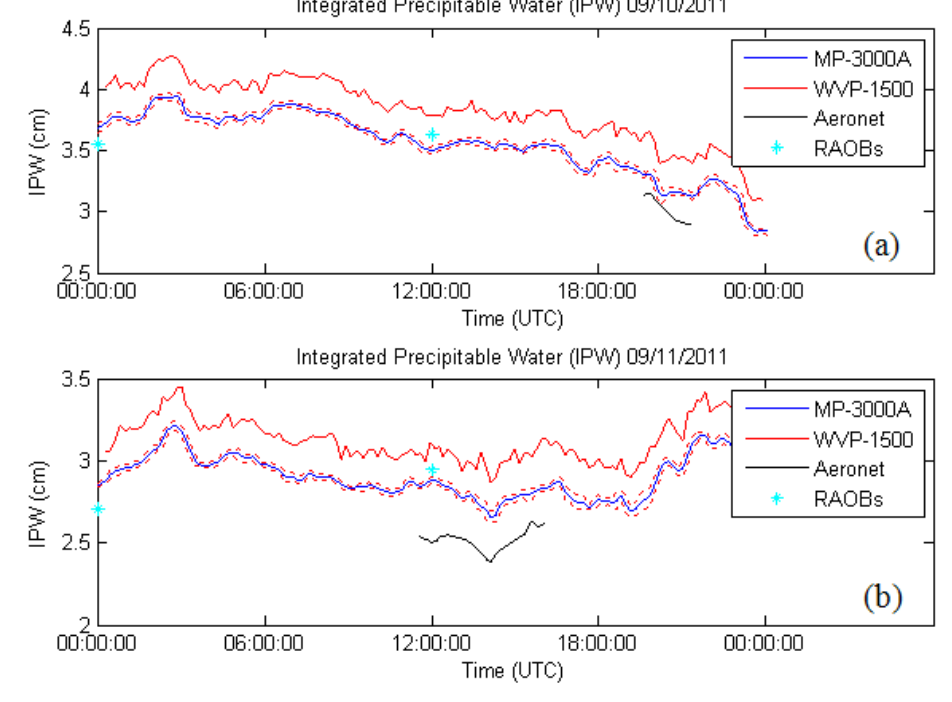
Figure 4. Inter-comparison of column Integrated precipitable water (IPW) from MP-3000A, WVP-1500 (microwave radiometers), AERONET and Radiosondes (RAOBs) for ( a ) 10 September 2011, and ( b ) 11 September 2011. Red lines with which blue line is flanked represents the interval of confidence for the MP-3000A dataset based solely on temporal fluctuations of